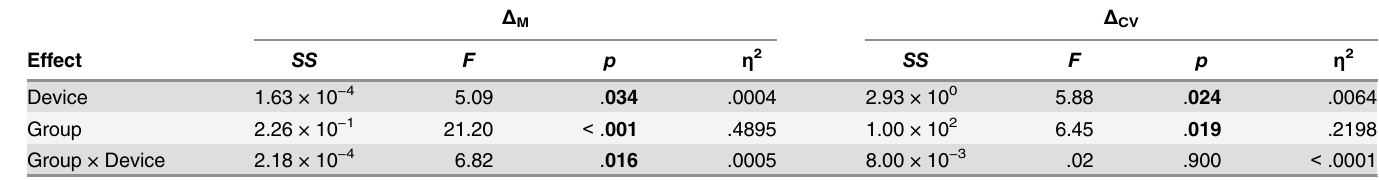
Table 6. Statistics associated with the Group × Device ANOVA for step length outcome measures during self-paced walking.